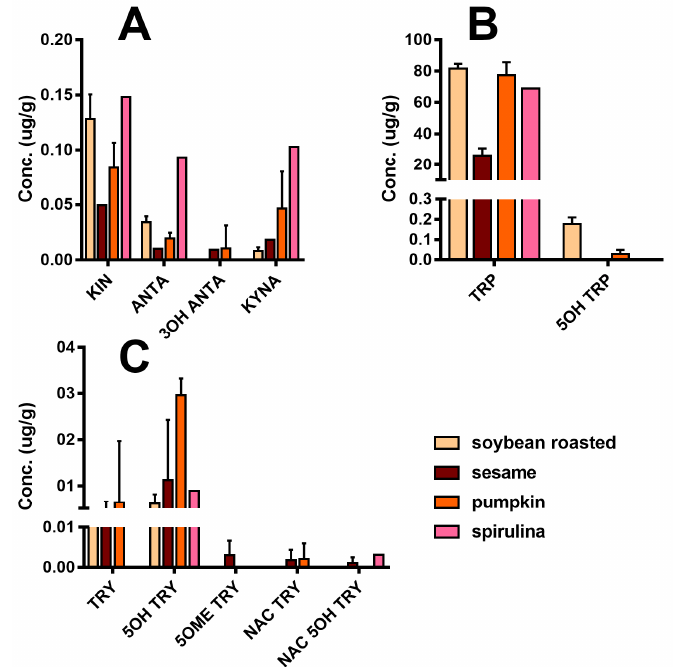
Figure 5. Indole compounds profile of plant extracts taking into consideration the water extraction at room temperature (concentrations are expressed as µg/g of plant materials ± SD): ( A ) Compounds derived from TRP catabolism, ( B ) TRP related compounds, and ( C ) Substituted tryptamines.